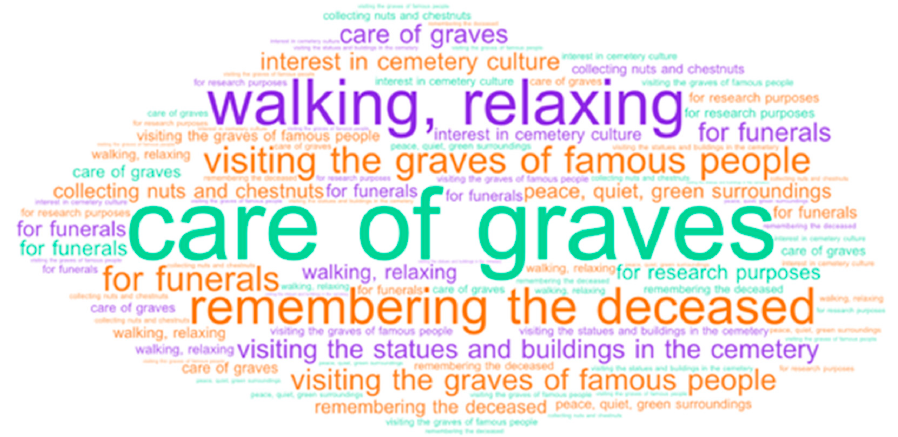
Figure 1. Word cloud: the diversity of purposes for visiting a cemetery, based on [1] (by authors). Cemeteries and burial grounds are primarily considered sacred places, closely linked to the history of a local community, but also custodians of natural and cultural values [6]. According to Skår (2018) and Maddrell (2016) [7,8], cemetery as a term refers mainly to the process of grieving and the dignified remembrance, but also to the management and maintenance of cemeteries [9]. However, cemeteries are an integral part of our neighbor- hoods, cities and society [10].